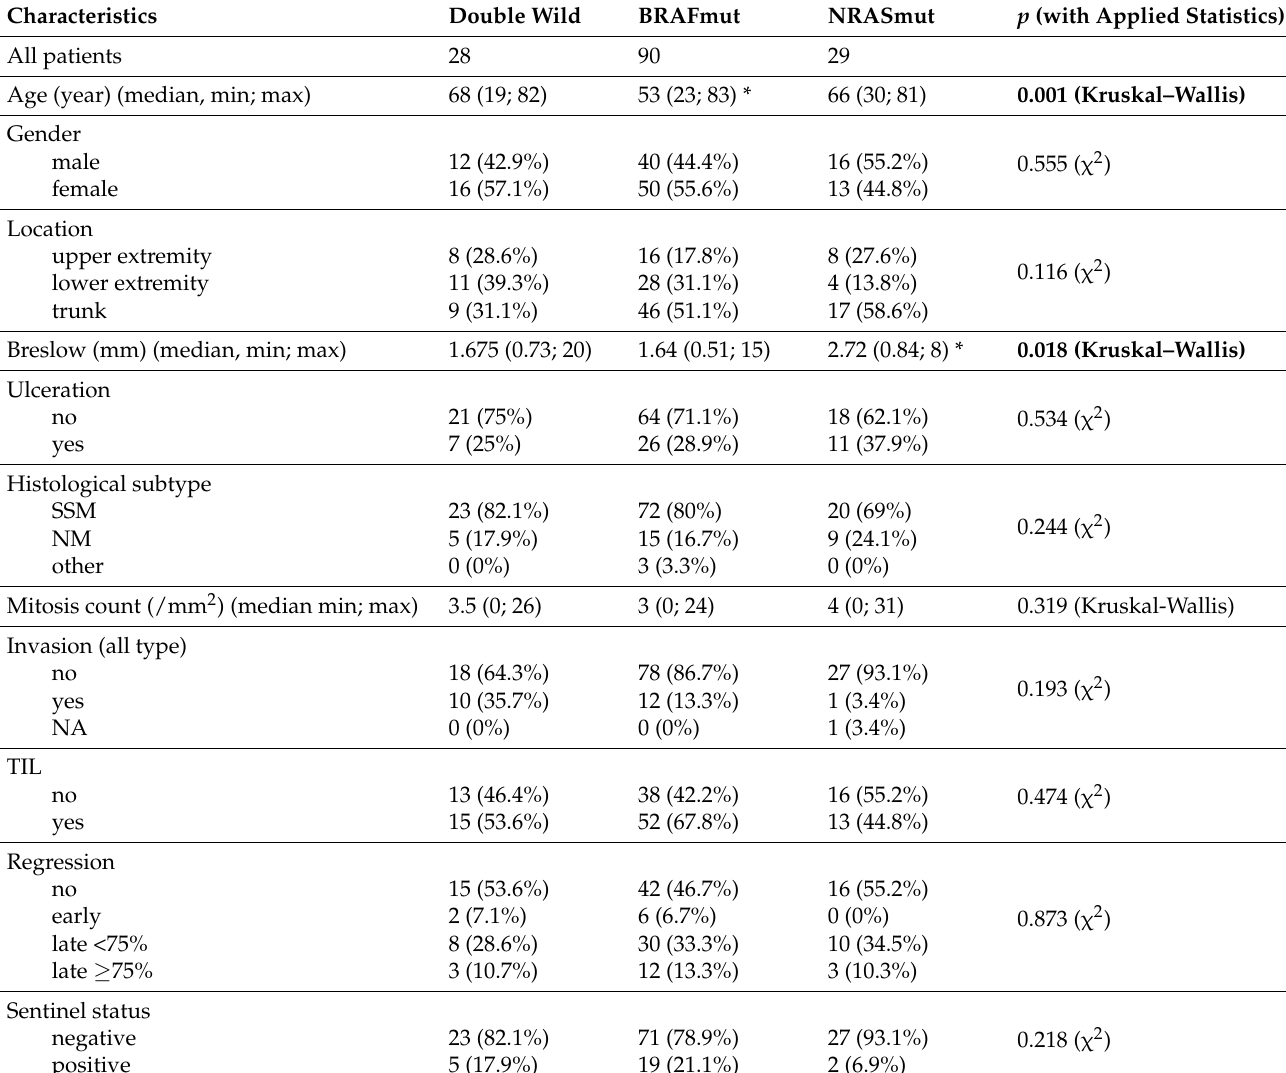
Table 4. Distributional differences of melanoma patients by molecular subtype (asterisk indicates a significant difference by the post hoc